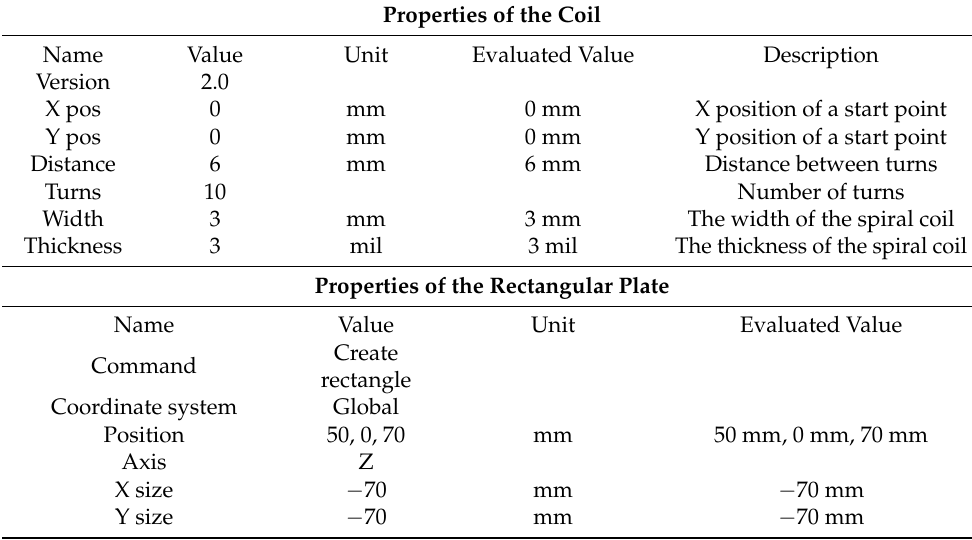
Figure 4. Design of the transmitter and receiver coils. Table 1 lists the properties of the coil and the rectangular plate. Table 1. Properties of the coil and the rectangular plate.